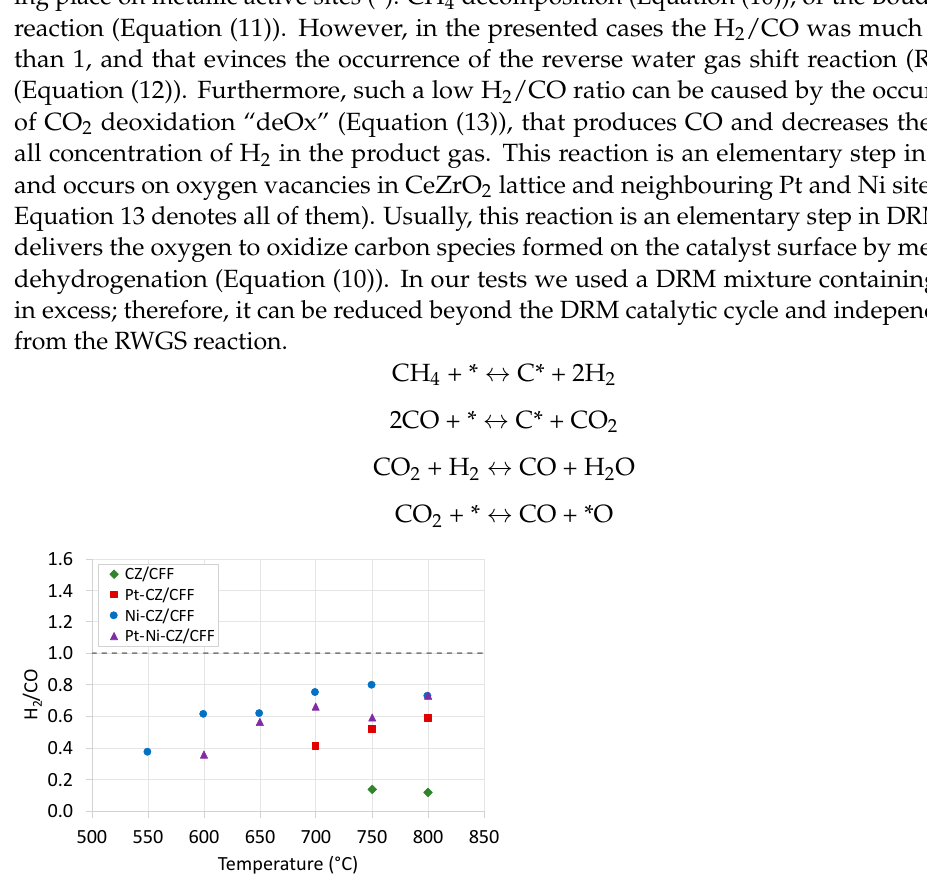
Figure 11. The H 2 /CO ratio during DRM over CZ/CFF, Pt-CZ/CFF, Ni-CZ/CFF and Pt-Ni-CZ/CFF. Reaction mixture: 4 vol. % CH 4 , 10 vol. % CO 2 , balanced with Ar. GHSV = 5000 h − 1 . TOS = 2 h.